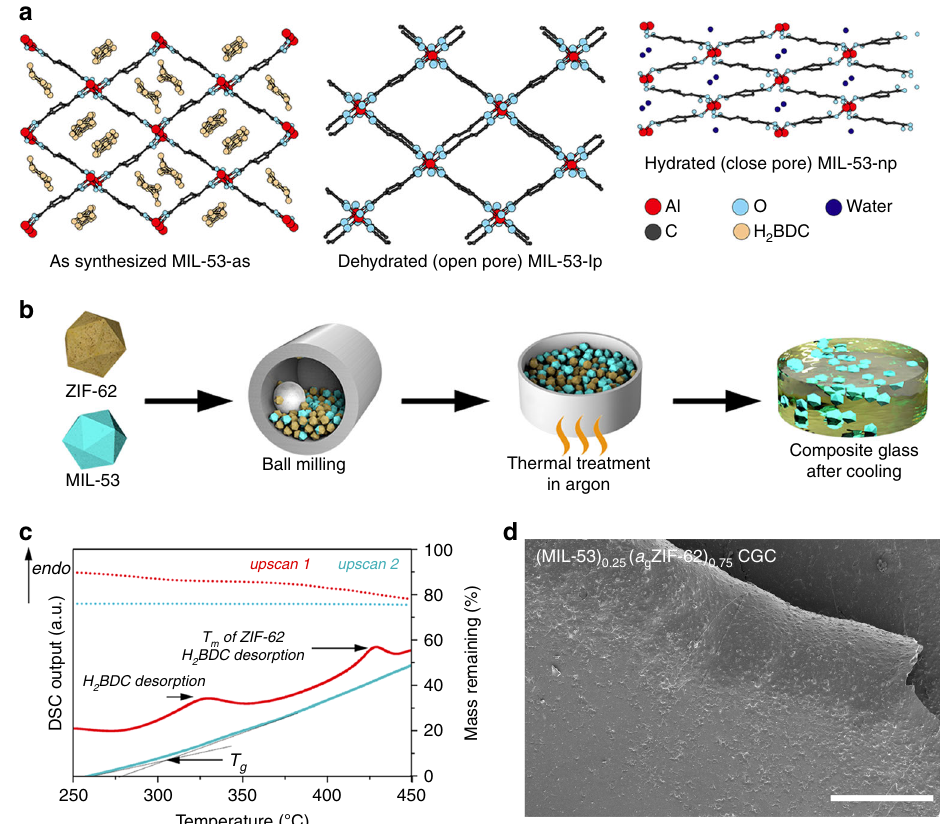
Fig. 1 Fabrication of crystal-glass composites. a Schematic diagram of the crystal structure of different MIL-53 forms 28 . b Schematic diagram of the CGC fabrication process. c Thermogravimetric (dotted line) and enthalpic responses (solid line) of (MIL-53)(ZIF-62)(25/75) mixture on both the fi rst (red) and second (blue) DSC heating upscans at 10 °C min − 1 . Melting temperature (offset temperature of the melting peak, T m ), glass transition temperature (onset temperature of glass transition peak, T g ) and H 2 BDC desorption are indicated. d SEM image of the (MIL-53) 0.25 ( a g ZIF-62) 0.75 CGC. Scale bar is 200 µ